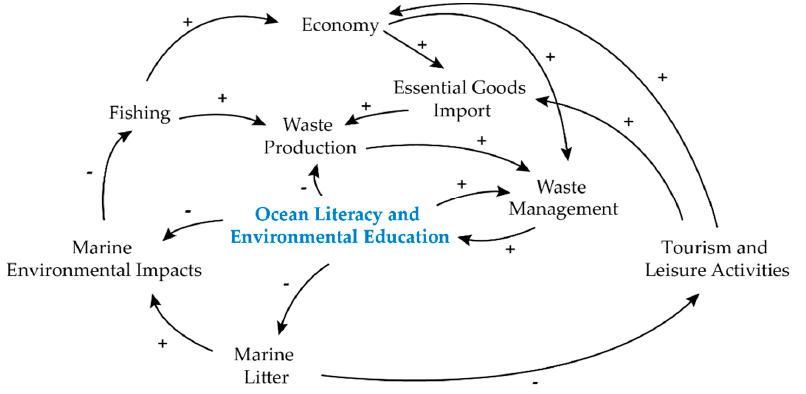
Figure 7. Simplified casual loop diagram of marine litter in fishing island coastal communities in Cape Verde.